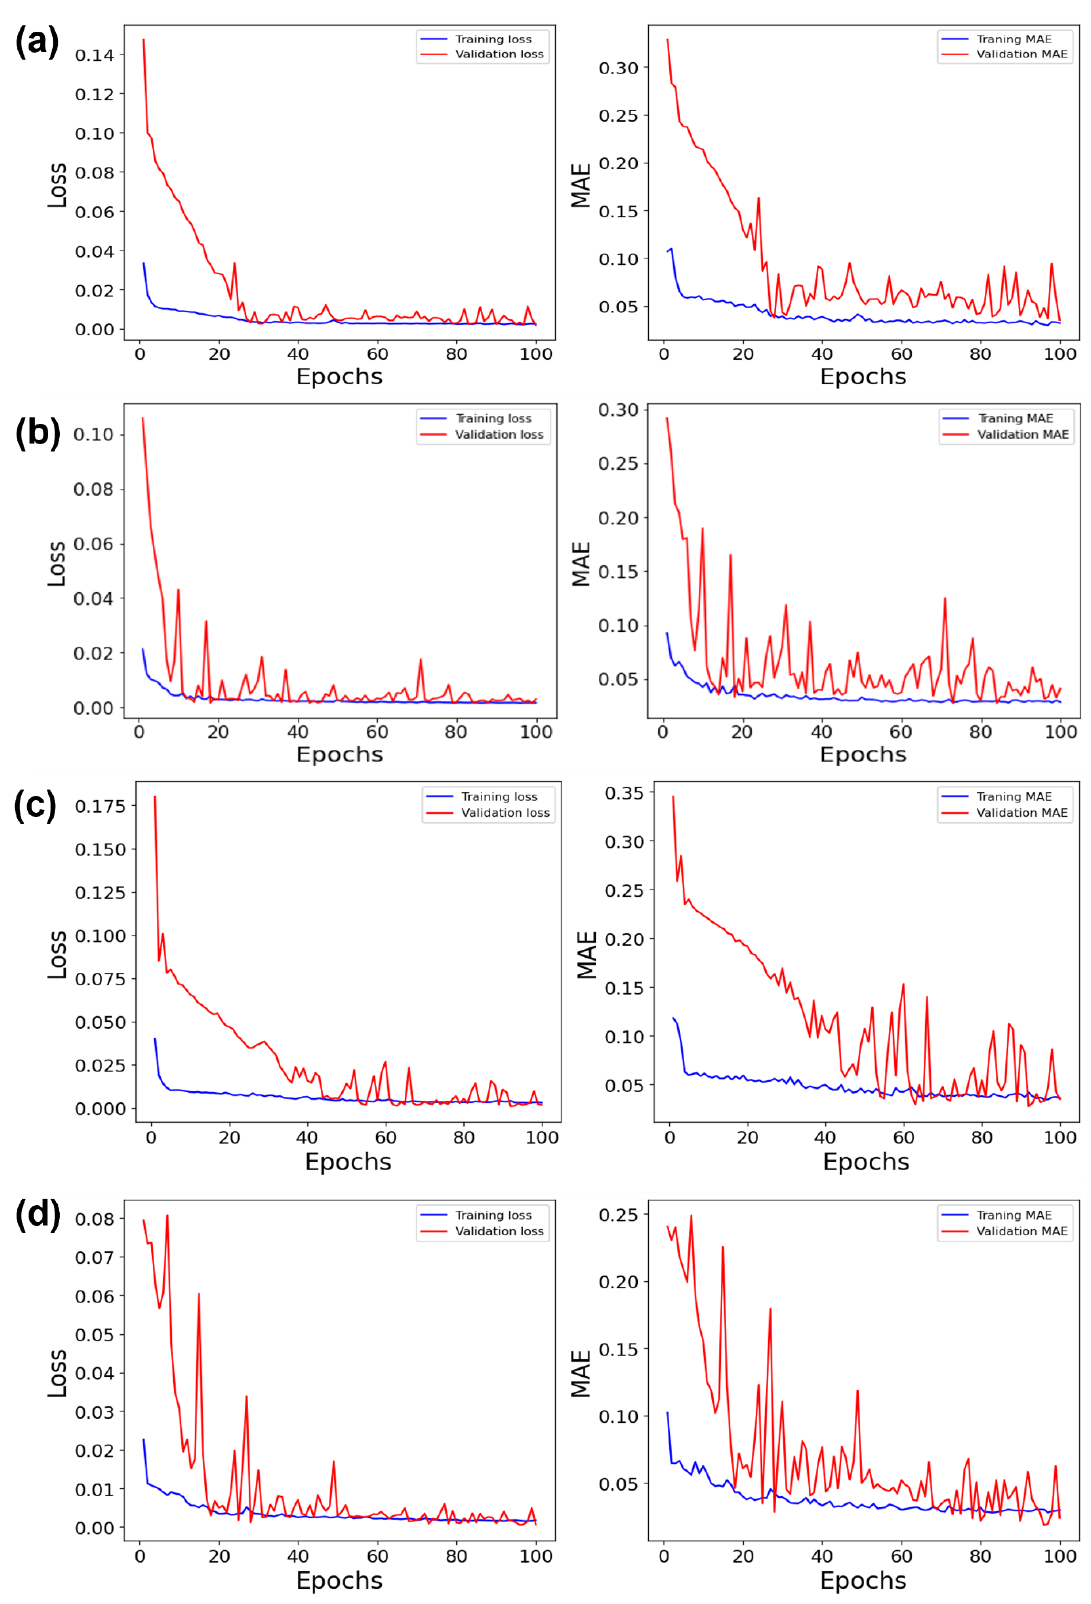
Figure 4. Hyperparameter tuning process for each LSTM model. Loss and MAE values of training and validation for: ( a ) LSTM1, ( b ) LSTM2, ( c ) LSTM3, and ( d )